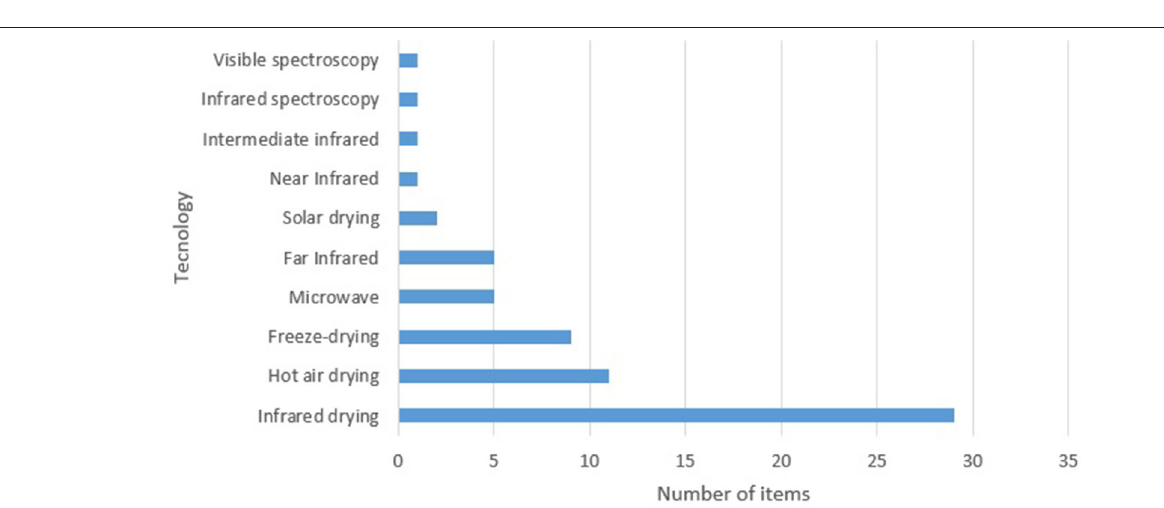
FIGURE 2 | Technologies found in the search. Source: the